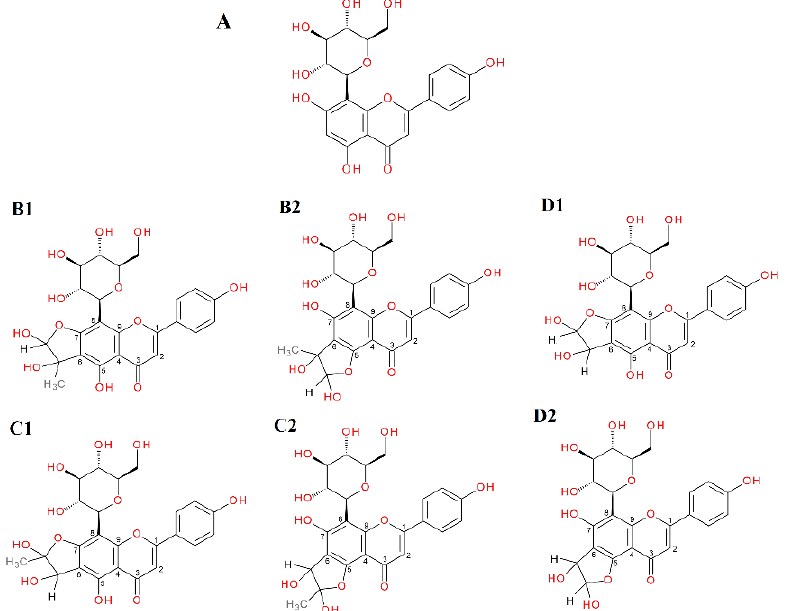
Figure 11. Proposals for chemical structures of adducts formed in the reaction of vitexin with methylglyoxal/glyoxal after 1 h of incubation in pH 7.4 phosphate buffer solution at 37 ◦ C; ( A ), vitexin; ( B1 , B2 ), hemiacetal forms of mono-MGO-vitexin; ( C1 , C2 ), hemiketal forms of mono-MGO-vitexin; ( D1 , D2 ), mono-GO-vitexin isomers. Other isomers are also